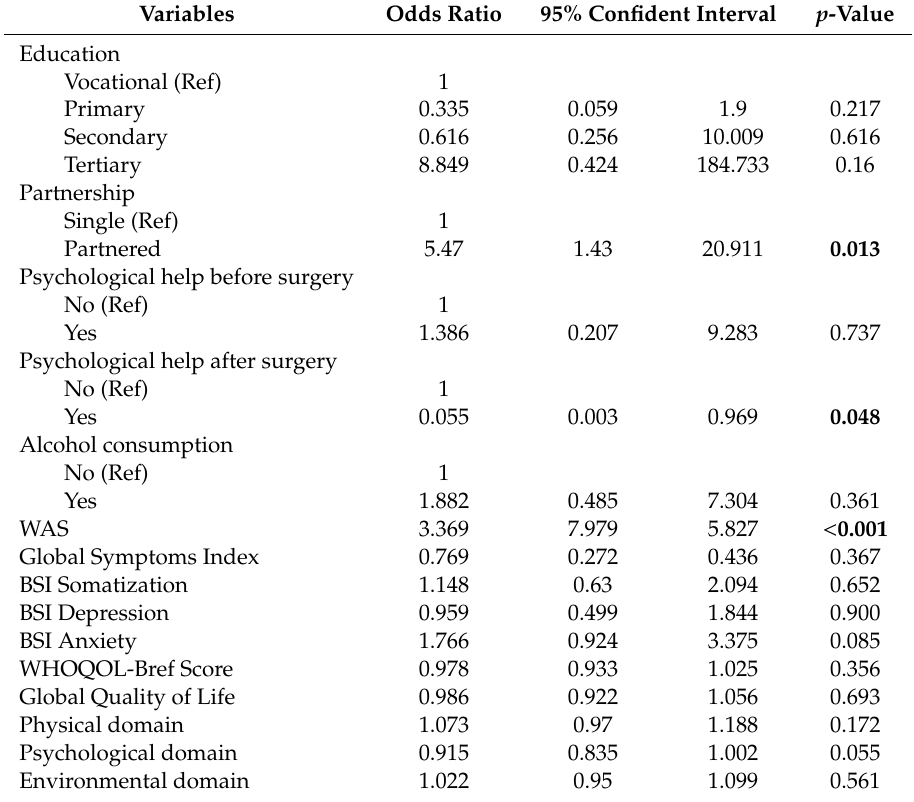
Table 4. Variables associated with current employment in kidney transplant recipients. Unadjusted logistical regression model assessing variables which are associated with current employment in kidney transplant recipients (employment status as dependable variable). Variables included in the model were chosen based on the univariate analysis with a cuto ff point of p <